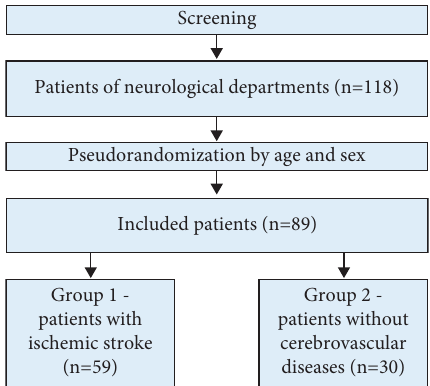
Figure 1: Study selection process. Te authors screened 118 patients in neurological departments who met the criteria listed as follows. After pseudorandomization, the authors include 89 patients in this study. Group 1 consists of 59 patients with ischemic stroke. Group 2 contains 30 patients without cerebrovascular pathology. Table 1: Demographic and clinical characteristics of studied